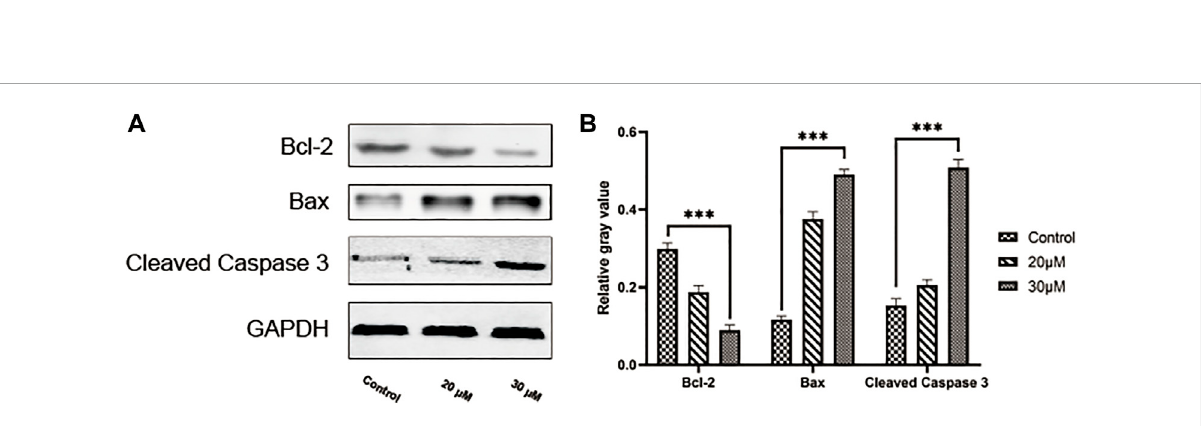
FIGURE 8 Evaluation of cell apoptosis by western blot. Blots showing proteins in the SK-MEL-1 cells treated with curcumin in different concentrations (A) and quanti fi cation (B) . **p < 0.01, ***p < 0.001 and ****p < 0.0001, one-way